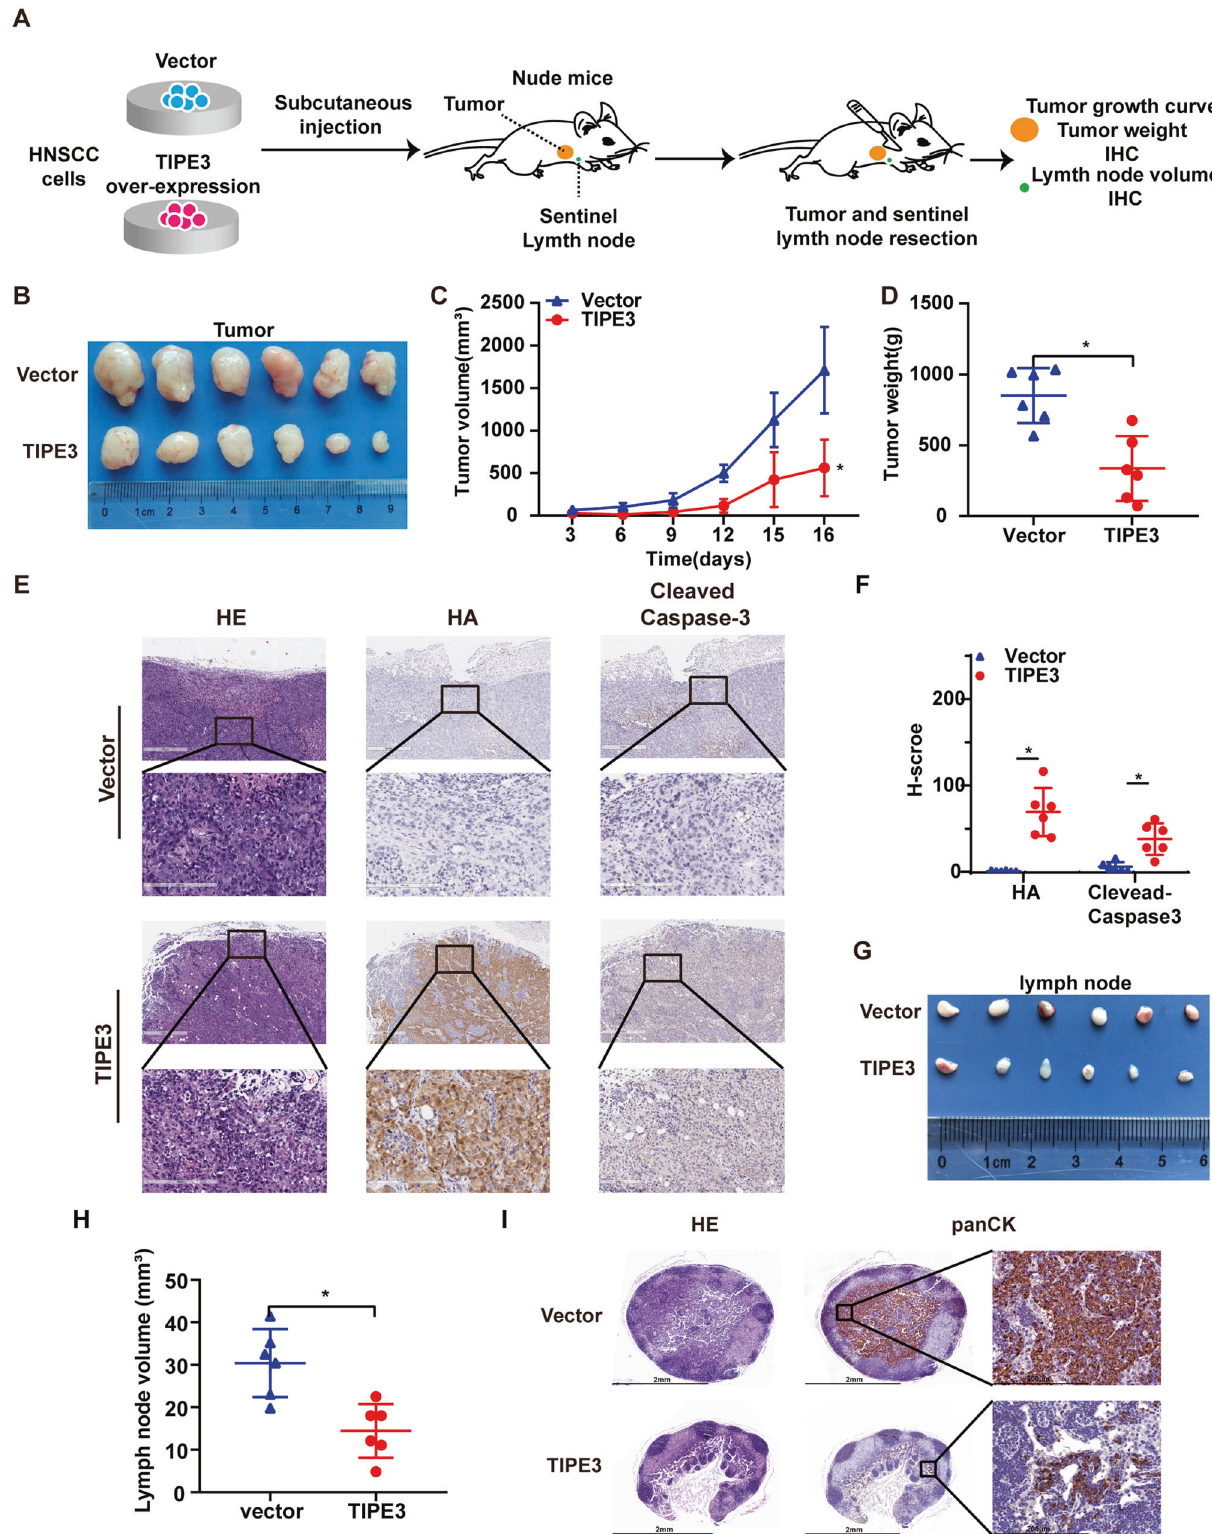
Fig. 7 TIPE3 represses HNSCC tumor growth and metastasis in vivo. A HN6 cells stably overexpressed the vector or TIPE3 ( n = 6 per group) were injected into the subcutaneous of mice to construct axillary lymph node metastasis models. B Representative images of primary tumors. C , D The volumes ( C ) and weights ( D ) of primary tumors. E , F Representative images ( E ) and quanti fi cation ( F ) of the expressions of HA, PGAM5, and cleaved-caspase3 in primary tumors determined by IHC staining. G , H Representative images ( G ) and quanti fi cation ( H ) of the average volumes of inguinal lymph nodes. I IHC staining of pan-cytokeratin-positive tumor cells in inguinal lymph nodes. Mean ± s.d.; * P < 0.05 compared with vector; Student ’ s t-tests.